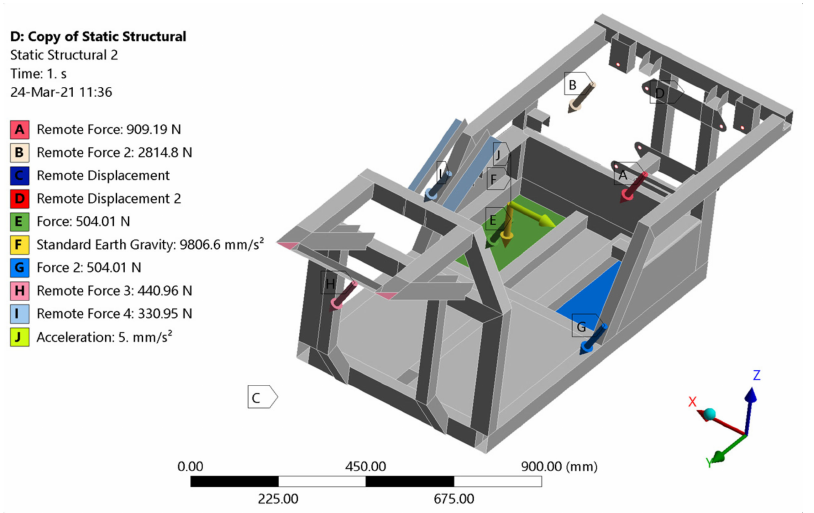
Figure 13. Boundary conditions of the second limit